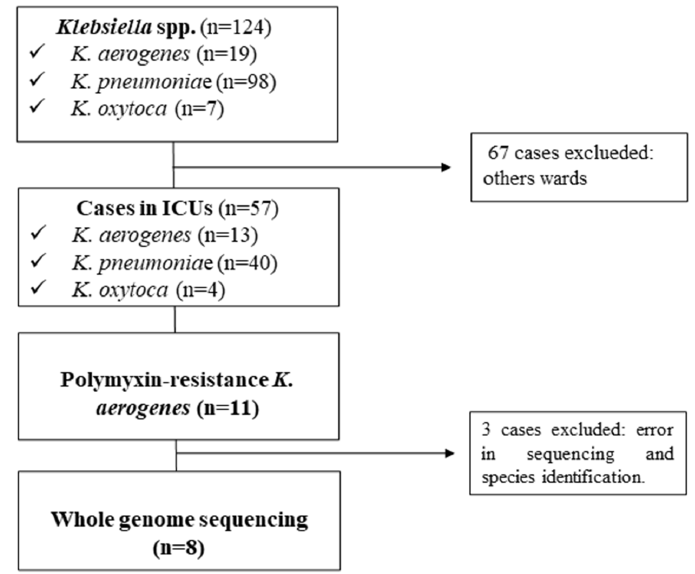
Figure 2. Flowchart of the study